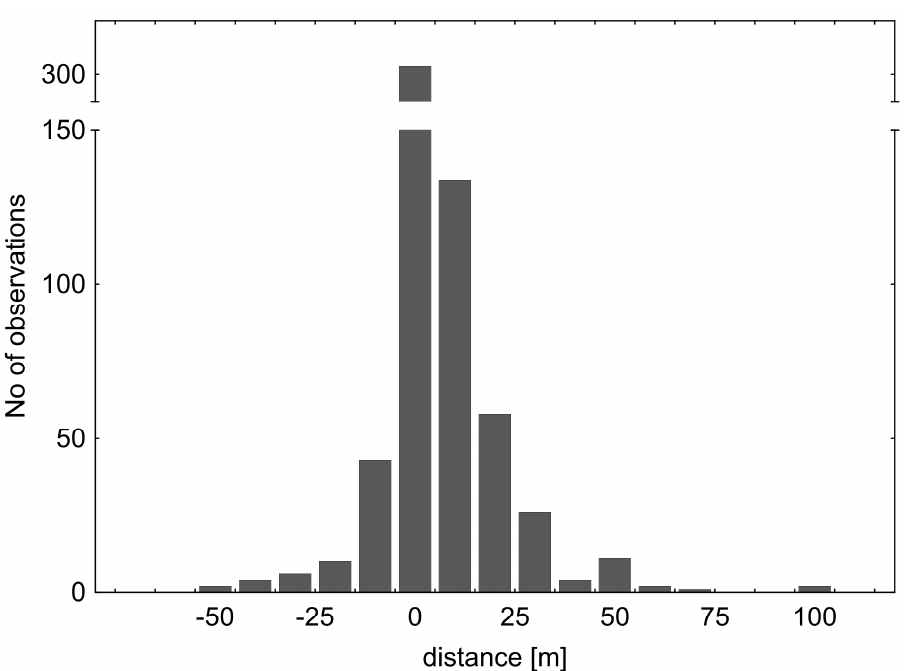
Figure 9. Total distance recorded for the water cricket V. caprai . Although most of the bugs stayed at the original site, more individuals moved upstream (positive numbers) than downstream (negative numbers). The upstream movement exceeded even 100 m.